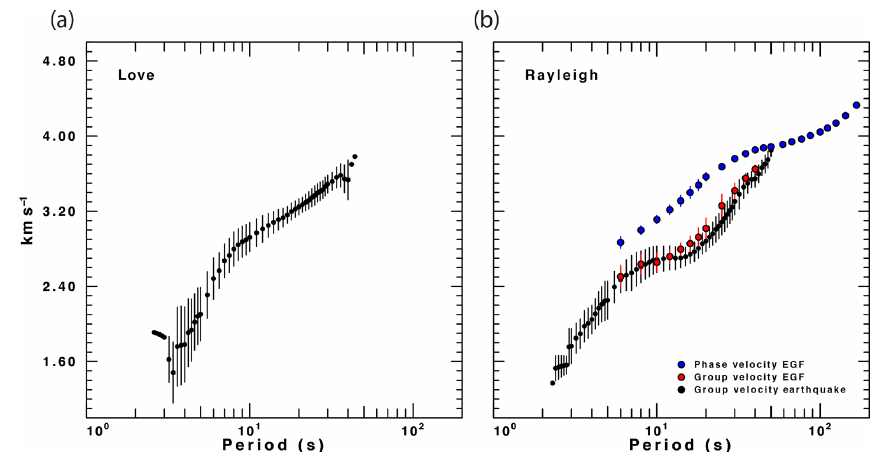
Figure 2. Dispersion measurements used to obtain the VALEN 1-D model for waveform inversion. Group velocities from earthquakes are shown as black circles, group velocities from noise as red circles, and phase velocities from noise shown as blue circles. Vertical error bars indicate measurement uncertainty (standard deviation). For phase velocities some error bars are smaller than the symbol size. (a) Love-wave dispersion measurements, and (b) Rayleigh-wave dispersion measurements.